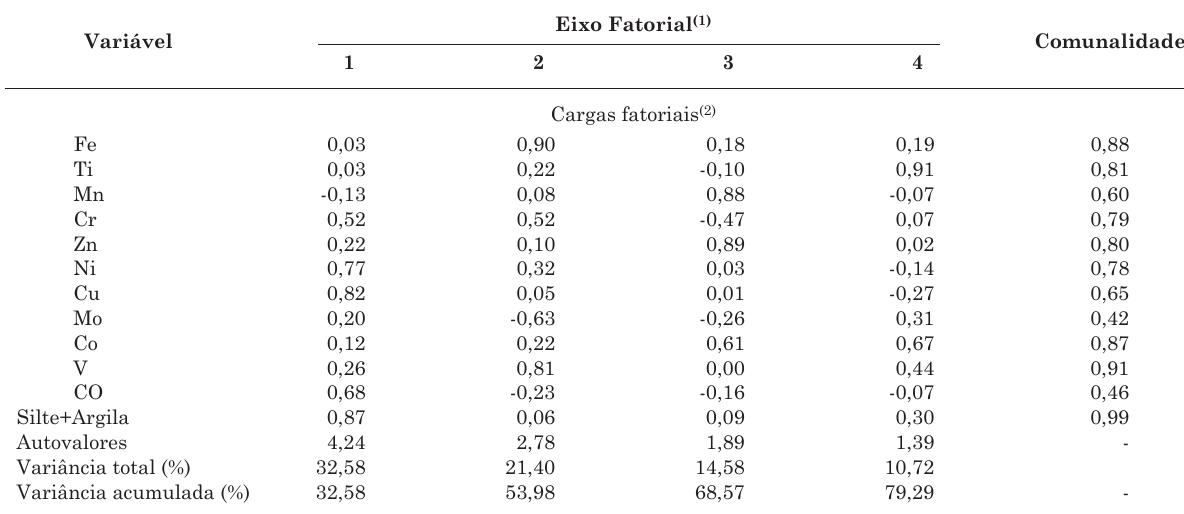
(1) eixos fatoriais rotacionados pelo método varimax. (2) cargas fatoriais ≥ 0,65 foram consideradas significantes para fins de